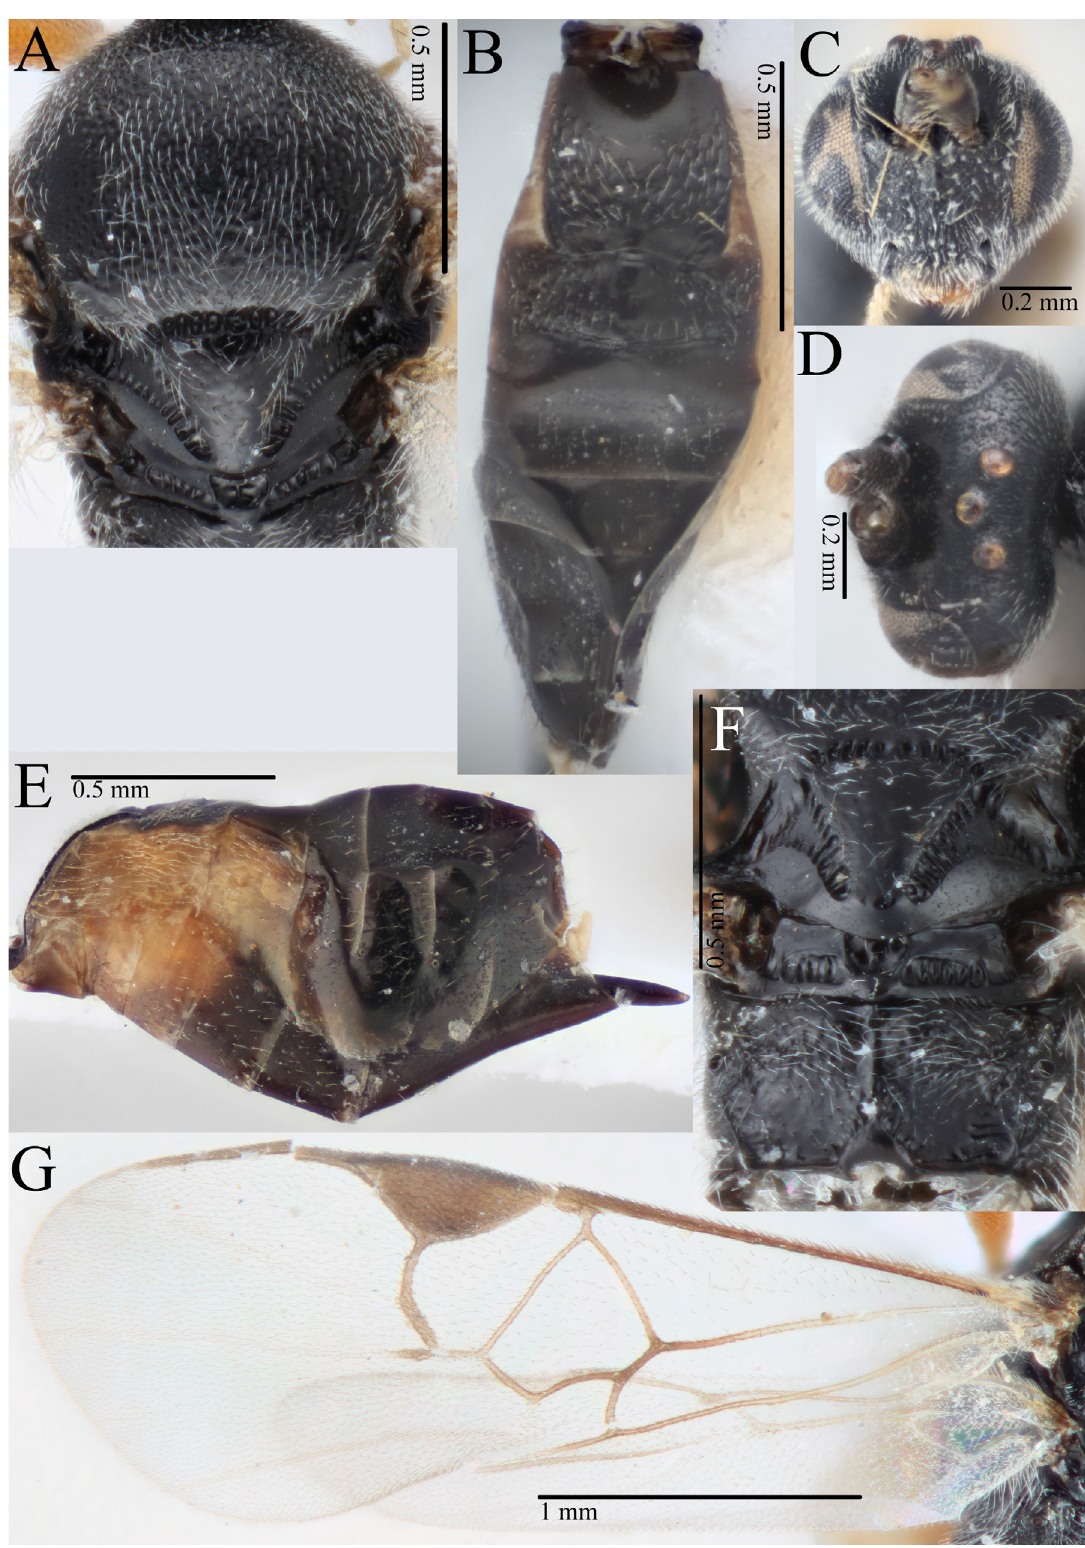
Fig. 29. Cotesia scripta sp. nov. A–C, E–G . Holotype, ♀ (MV T22495). D . Paratype, ♀ (MV T22499). A . Anteromesoscutum. B . Metasoma in dorsal view. C . Head in anterior view. D . Head in dorsal view. E . Metasoma in lateral view. F . Mesoscutellum and propodeum. G .